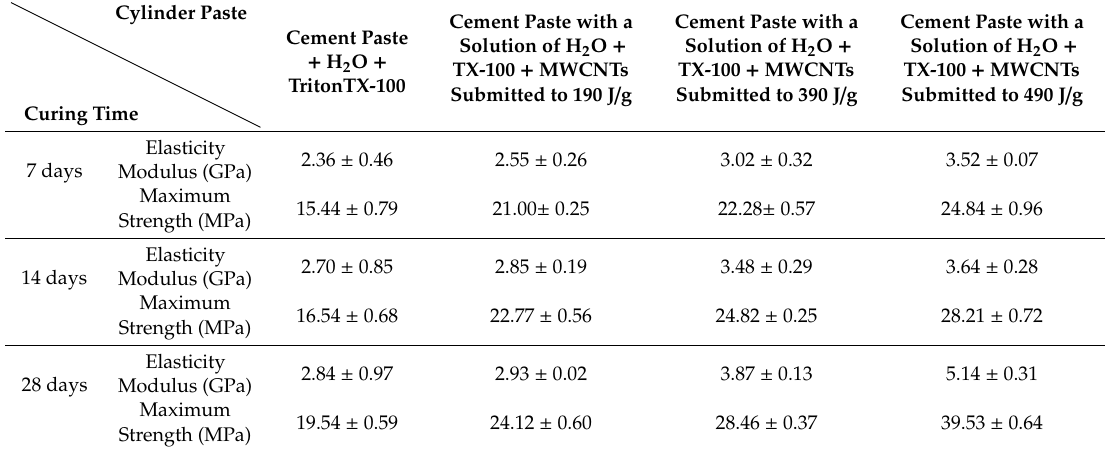
Table 3. Summary of results from quasi-static compression tests Portland cement specimens performed with an MWCNTs at four repose